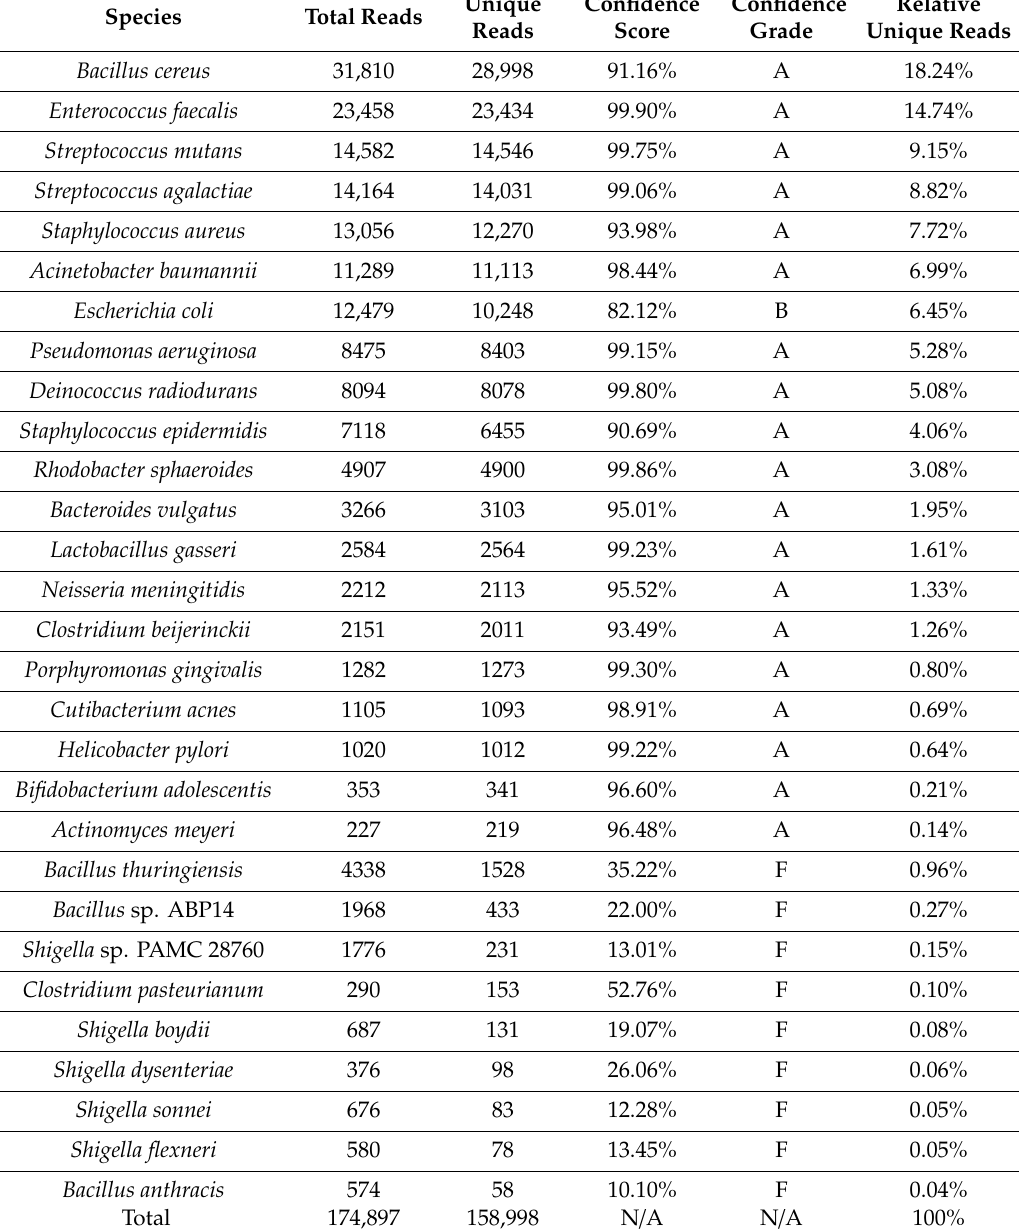
Table 2. Filtered Centrifuge results showing all 29 species identified in the MSA-2002 sample. Total reads are reads classified to species including multi-classified reads. Unique reads are those classified to a single species. The confidence score is the percentage of unique reads to total reads. The confidence grades are simply ranges of confidence scores: A = 90–100%, B = 80–90%, C = 70–80%, D = 60–70%, F = 0–60%. The last column shows the relative abundance of unique reads—the percentage of species specific unique reads to total unique reads. Except for the incorrectly identified Actinomyces meyeri , it can be seen that the other 19 MSA-2002 species had high unique reads to total reads ratios (confidence grades of B or better), while the incorrectly identified near-neighbors had low confidence grades.